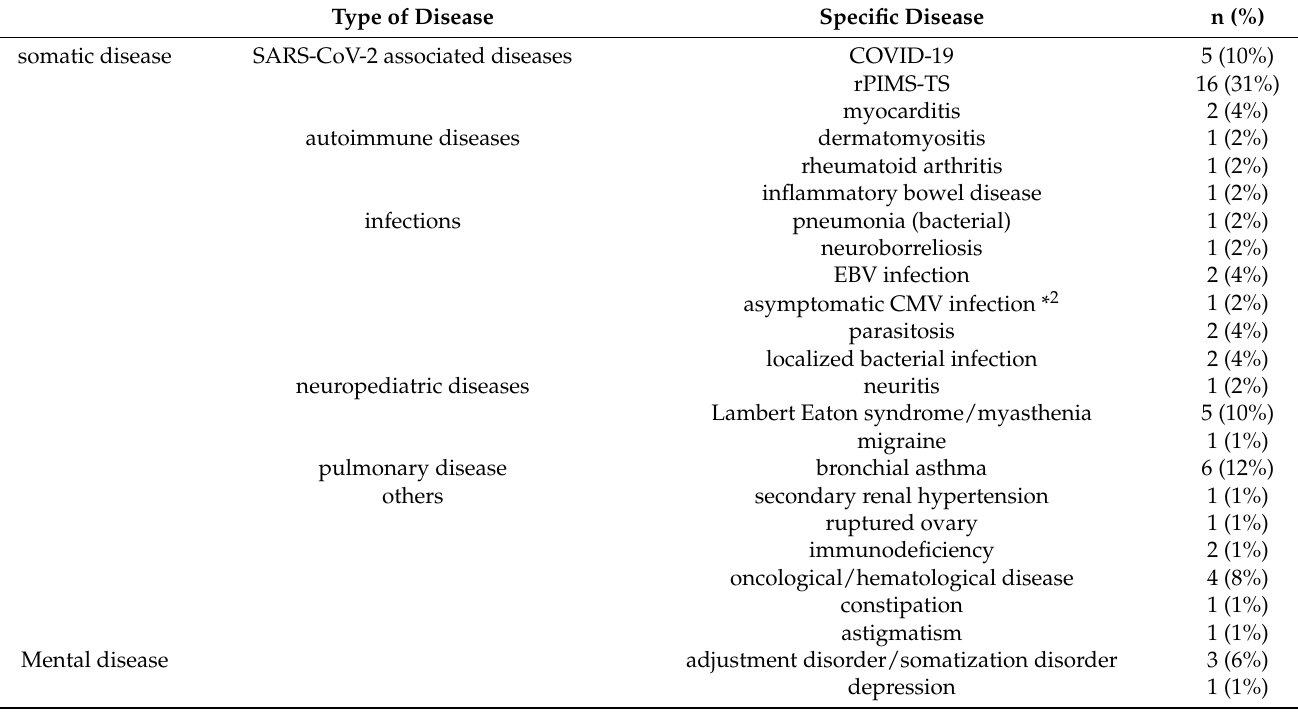
Table 3. Newly encountered diseases in patients with suspected long COVID * 1